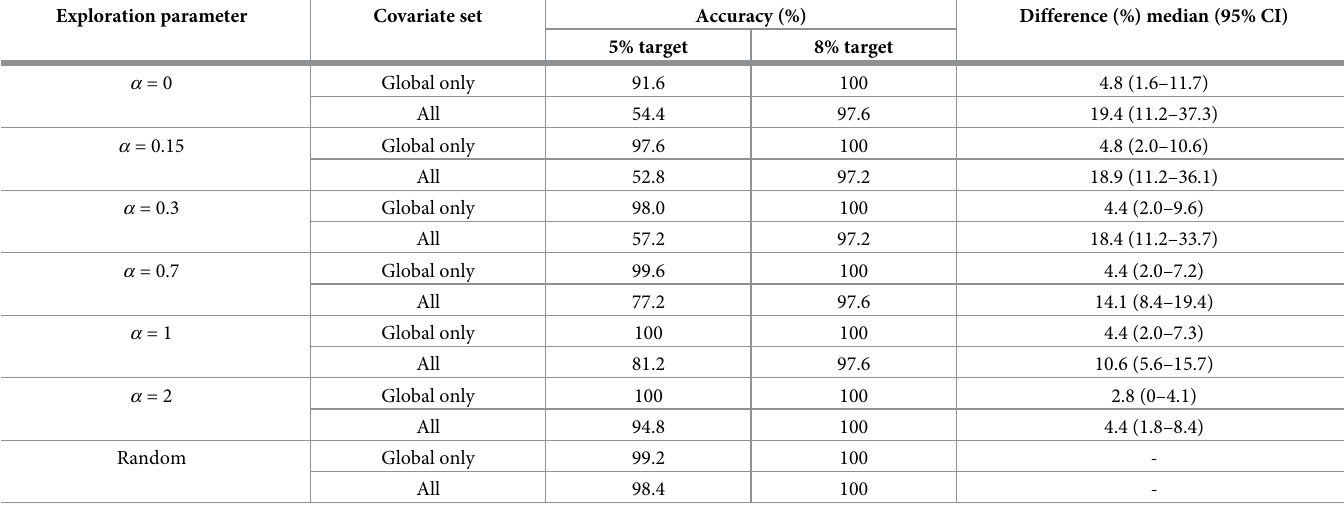
Table 2. Performance of adaptive sampling in the simulation study, compared to random sampling. Accuracy is the percentage of designs which met the control target, i.e. the out-of-sample infestation rate was below 5% (or 8%). Difference from random is the percentage of the village in the design, minus the corresponding percentage using random sampling, calculated for each initial